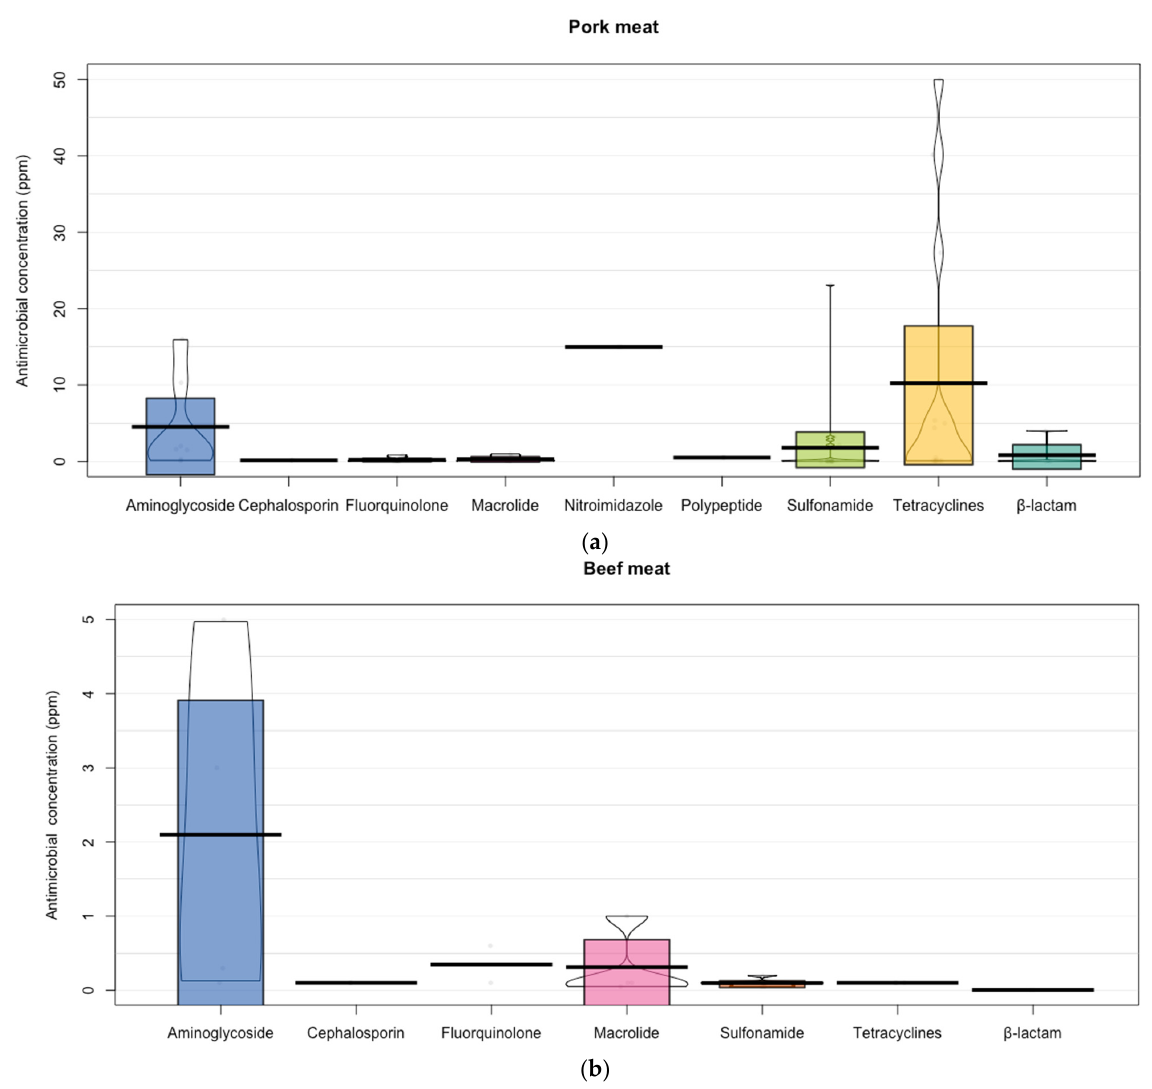
Figure 3. Presence of antibiotics in animal products. Points represent the raw data; bar/line is the descriptive statistic (mean); bean is the smoothed density curve showing the full data distribution; and brackets represent the confidence intervals.